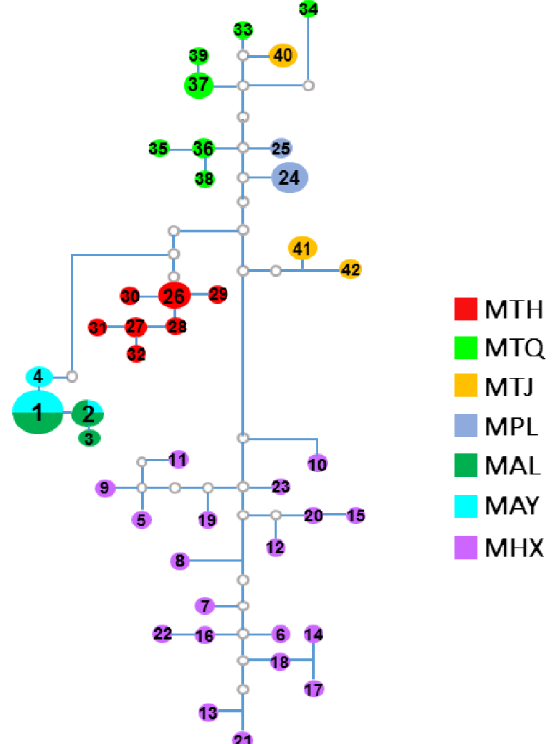
Figure 2. Median-joining network of Megalobrama fish mitochondria DNA (mtDNA) haplotypes based on 3.1 k mtDNA sequences. The area of the oval circle is approximately proportional to the haplotype frequency. Small gray circles on the lines connecting oval circles of haplotypes indicate substitutions. MTH, M. terminalis in the Heilong River; MTQ, M. terminalis in the Qiantang River; MTJ, M. terminalis in the Jinsha River Reservoir; MPL, M. pellegrini in the Longxi River; MAL, M. amblycephala in the Liangzi Lake; MAY, M. amblycephala in the Yi River and MHX, M. hoffmanni in the Xi River.